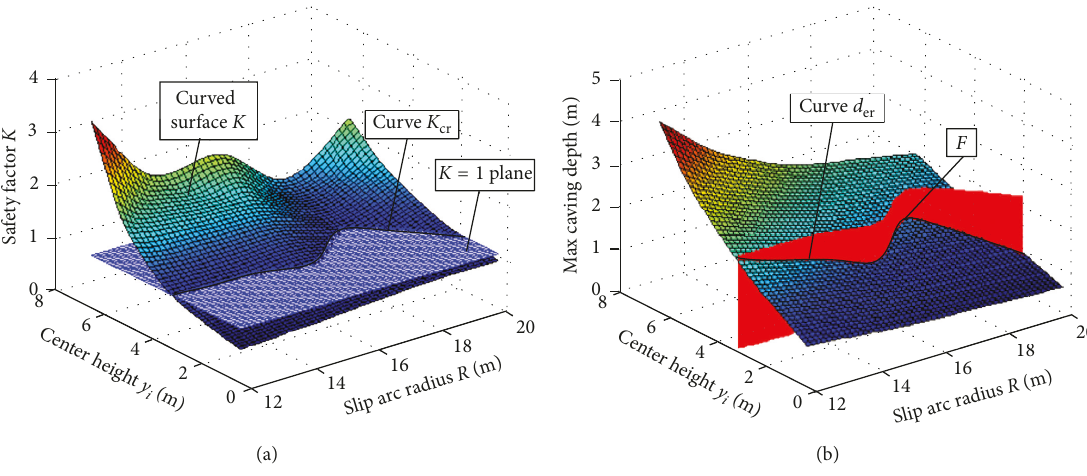
Figure 8: The determination of the critical slip